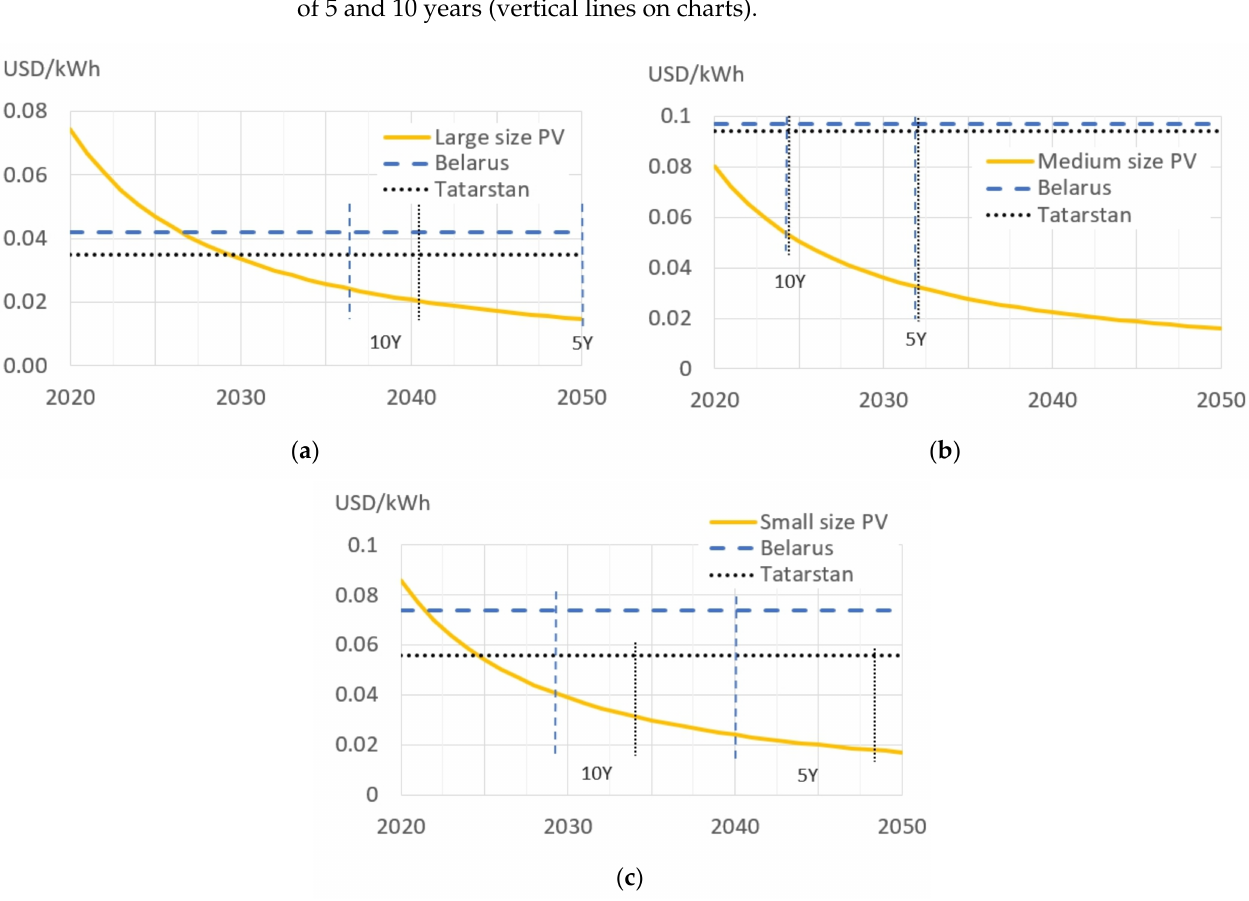
Figure 7. Forecast of levelized cost of electricity produced by ( a ) large, ( b ) medium-size, and ( c ) small PV systems compared to ( a ) average generation cost, ( b ) enterprise tariffs, and ( c ) household